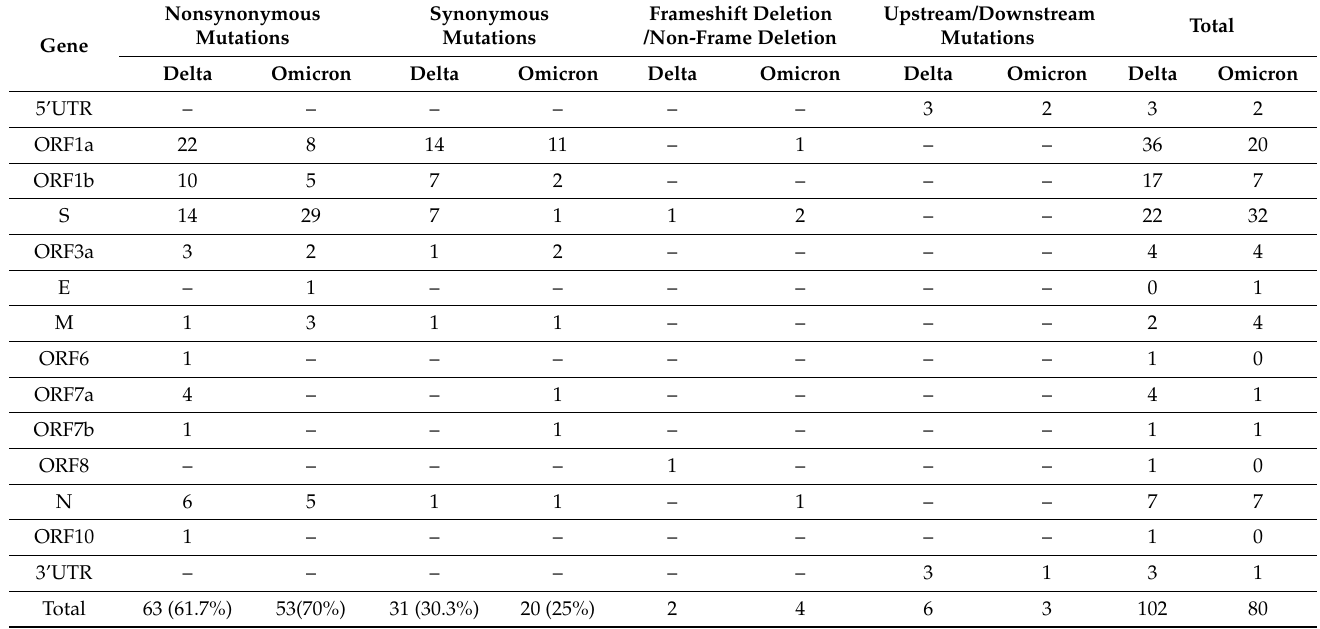
Table 1. ARS-CoV-2 genetic variations in the isolates from Duhok during the third and fifth waves of the pandemic compared to reference sequence